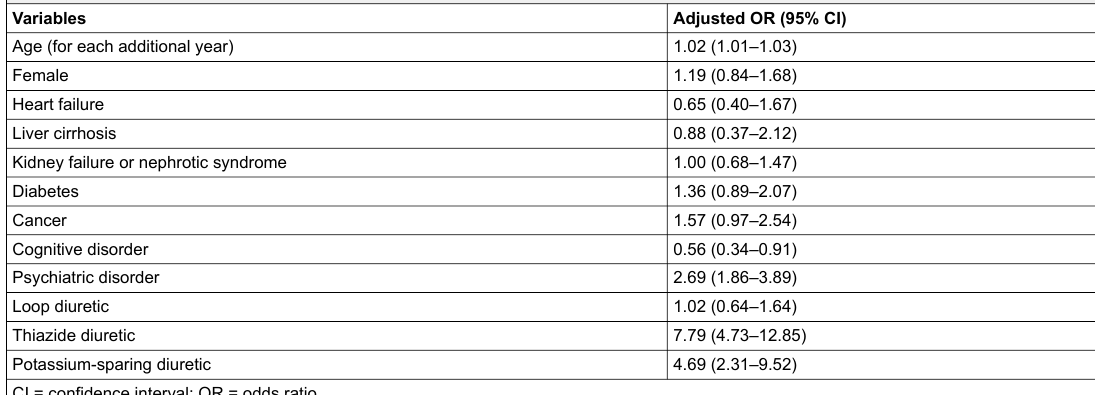
Table 4 : Risk factors for profound hyponatraemia in a multivariate analysis